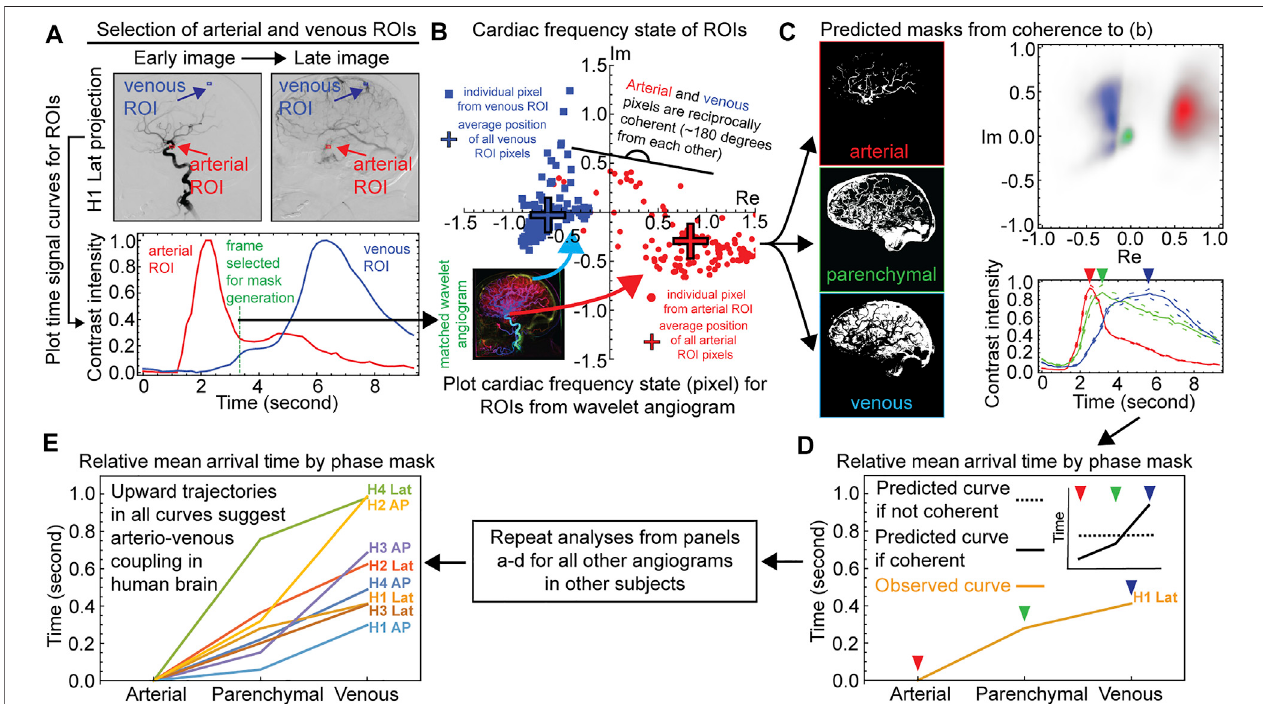
FIGURE 2 | Demonstration of reciprocal coherence between arterial and venous systems of the human brain. Example data for one angiographic projection from subject H1 are shown for panels a – c, data from all other projections are shown in Supplementary Figures S3, S4 Named Vessel ROIs, Right Common Carotid Artery Distribution,LateralProjection.ThetopleftshowsangiographicframesinarterialandvenousphasesofthebolustravelwithnamedarteryandveinROIs.Thebottomleft shows time signal curves for the two ROIs. The vertical gray bar indicates the frame selected for mask generation. The right panel shows complex-valued scattergramsforthetwoROIsafterwavelettransformationforcardiacfrequency.Framerate6.0 Hz.SubjectH1.c)TimeSignalCurvesFromCoherenceMasking,Right CommonCarotidArteryDistribution,LateralProjection.Theleftcolumnshowsthearterial,parenchymal,andvenouscoherencemasksasperthenamedarteryandvein ROIsinpanela.Thetoprightshowscomplex-valuedhistogramsofthewavelet-transformedcardiacfrequencydataforthemasks.Thebottomrightshowsangiographic time intensity curves generated from the masks are given with standard error. d-e) Relative mean arrival times from coherence masking for each subject, AP and lateral